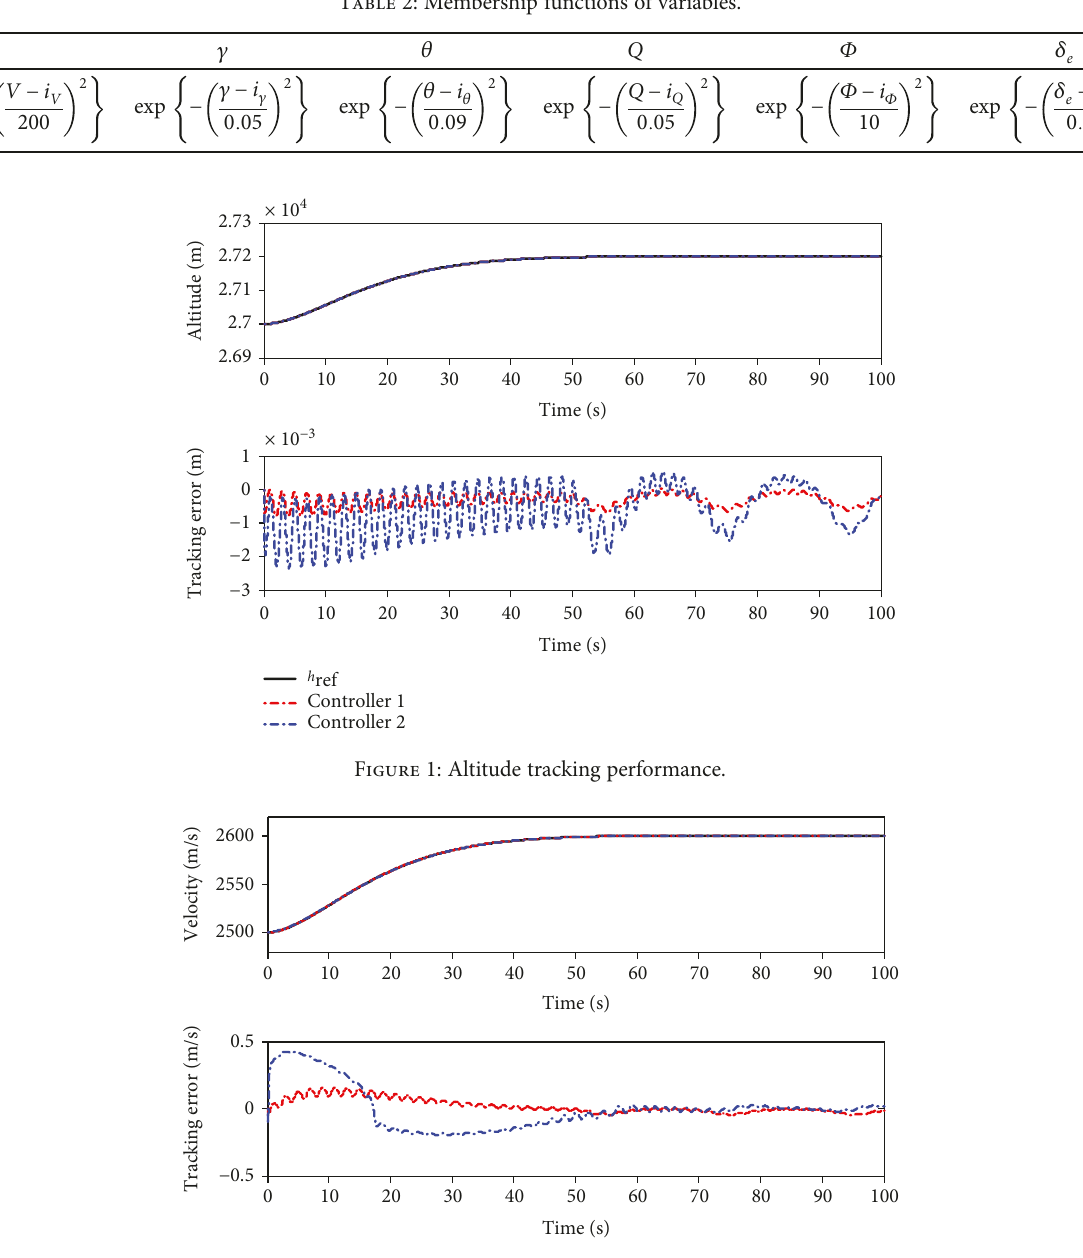
Table 2: Membership functions of variables.